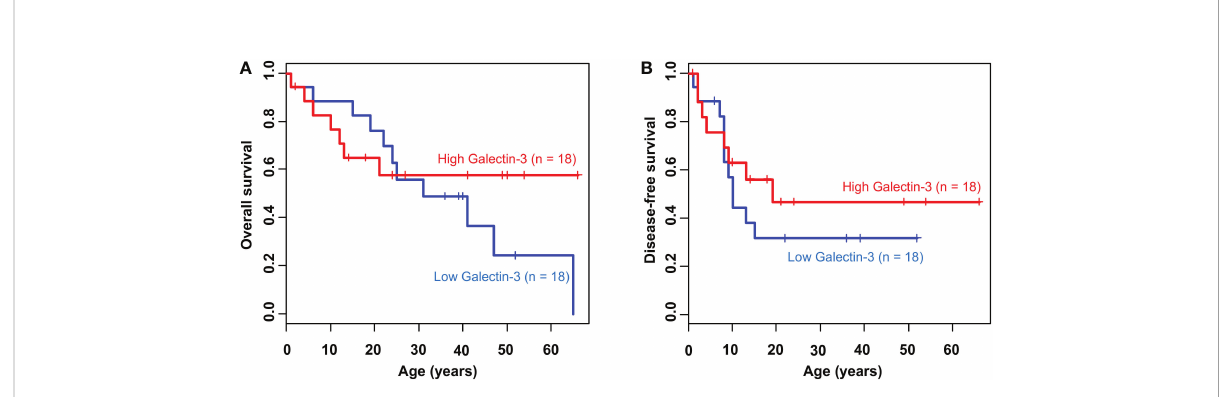
FIGURE 6 Kaplan-Meier survival curve of CCA patients according to galectin-3 expression. The cumulative (A) overall survival ( P = 0.54) and (B) disease-free survival ( P = 0.41) plot strati fi ed by the level of galectin-3